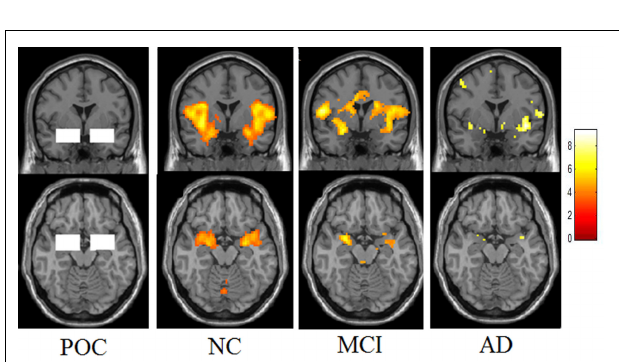
FIGURE 2 | The region of POC and activation maps of the three groups. This picture demonstrates the ROI of the POC region. Presenting the lavender stimuli of all three different concentrations, the NC showed obvious activation in the bilateral POC. The MCI showed decreased activation and the patients with Alzheimer’s disease showed the lowest